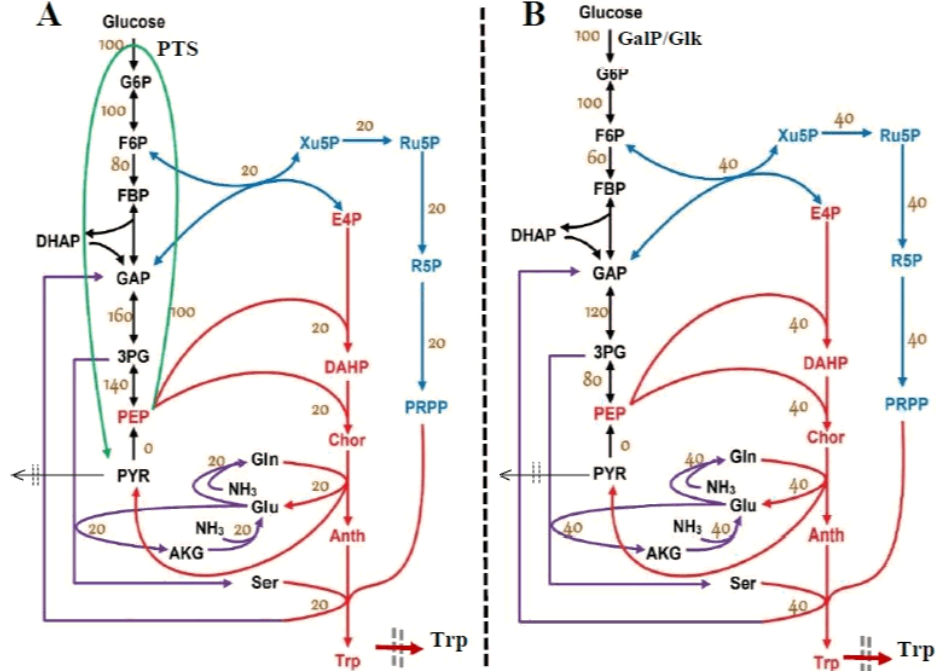
Figure 2. Comparison between the reduced schemes for GLC import systems into the cell linked to the TRP synthesis. Adapted from [73,74] (see the acknowledgement). ( A ) The wild E. coli model of Chassagnole et al. [52] and Maria [48] uses the phosphoenolpyruvate/sugar phosphotransferase (PTS) system for the GLC uptake. ( B ) The modified E. coli T5 strain of Chen et al. [73] and Chen [74], studied in this paper, uses the more efficient GLC uptake system based on galactose permease/glucokinase (GalP/Glk). The numbers on arrows indicated the relative metabolic fluxes at QSS predicted by Chen [74,75]. The same authors predicted a maximum theoretical yield of 0.23 g Trp/g glucose for the wild E. coli strain and of 0.45 g Trp/g glucose for the modified T5 strain.